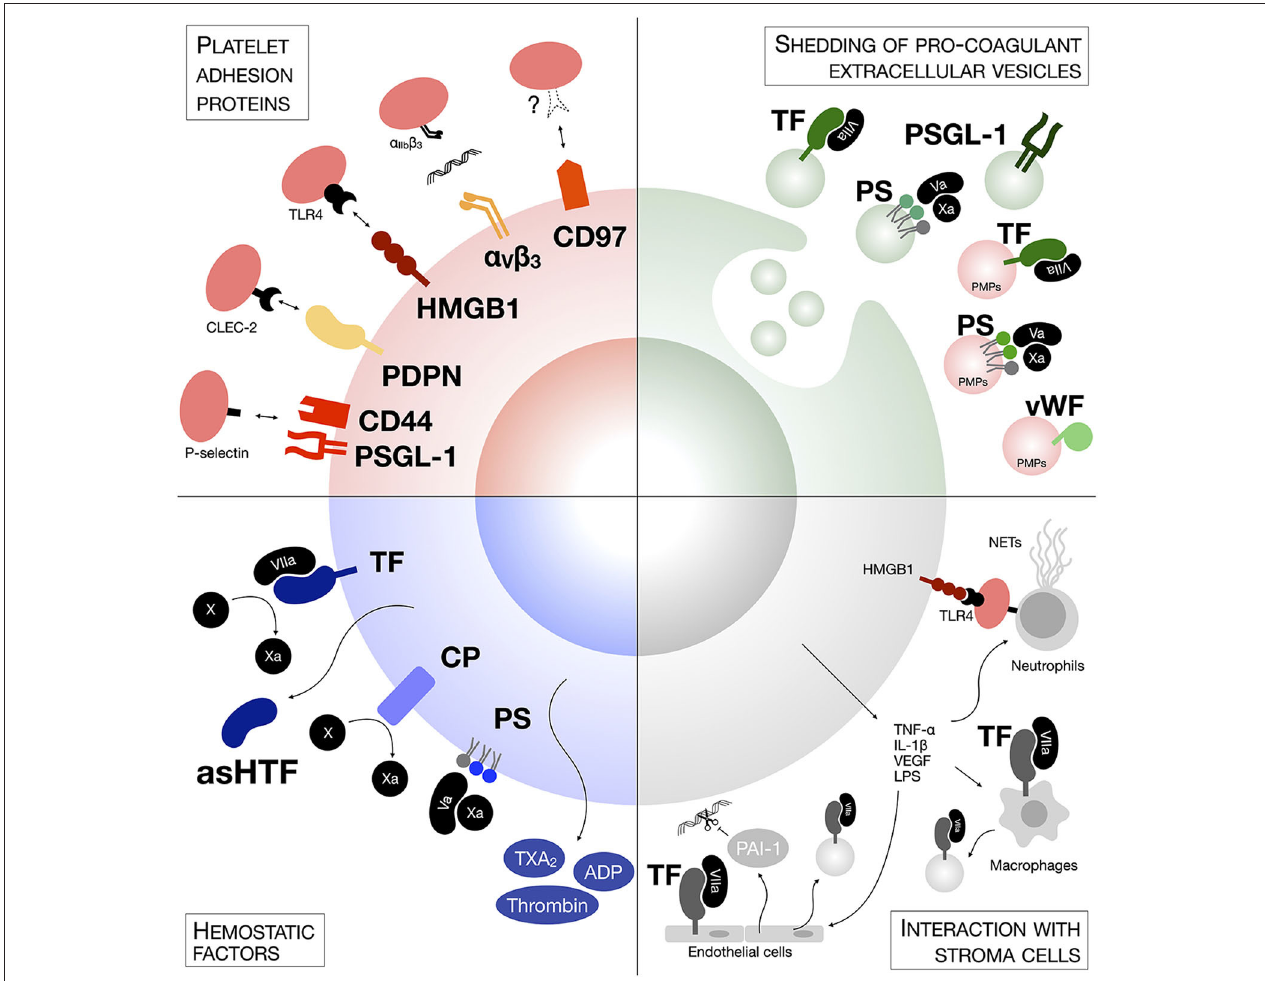
FIGURE 1 | Mechanisms of tumor cells-platelets interaction. Tumor cells generate platelet activation and the formation of microclots on their surface through several mechanisms, including expression of hemostatic factors and adhesion proteins, either on their surface or on the surface of shedded extracellular vesicles, or though the generation of a pro-thrombotic intravascular metastatic niche involving other stroma